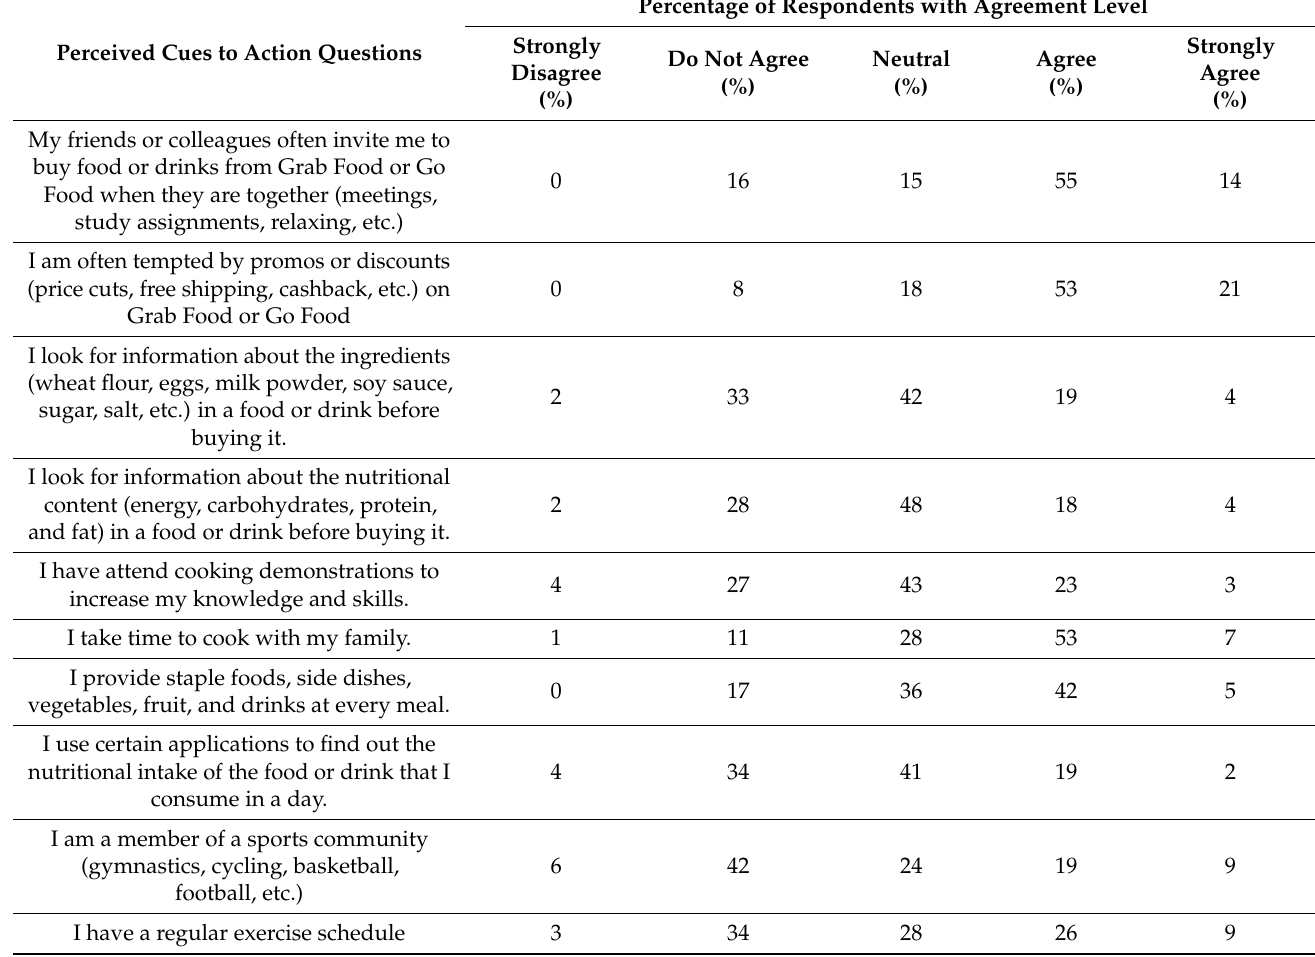
Table 8. Perceived cues to action